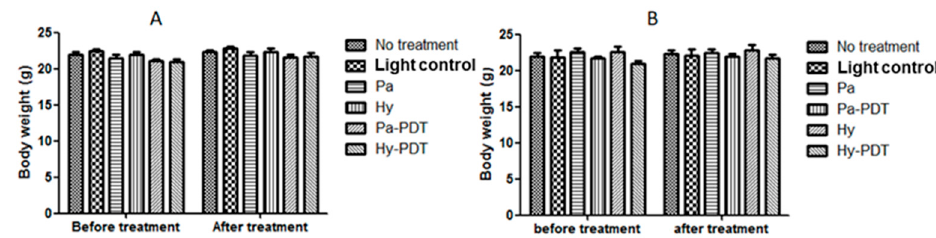
Figure 6. Body weight of different groups of mice after intravenous injection treatment with or without PDT. ( A ) Pa and Hy 2.5 mg/kg, irradiation for30 s for PDT groups; ( B ) Pa and Hy 2.5 mg/kg, irradiation for 10 min for PDT groups. Data are mean ± SEM ( n =5).